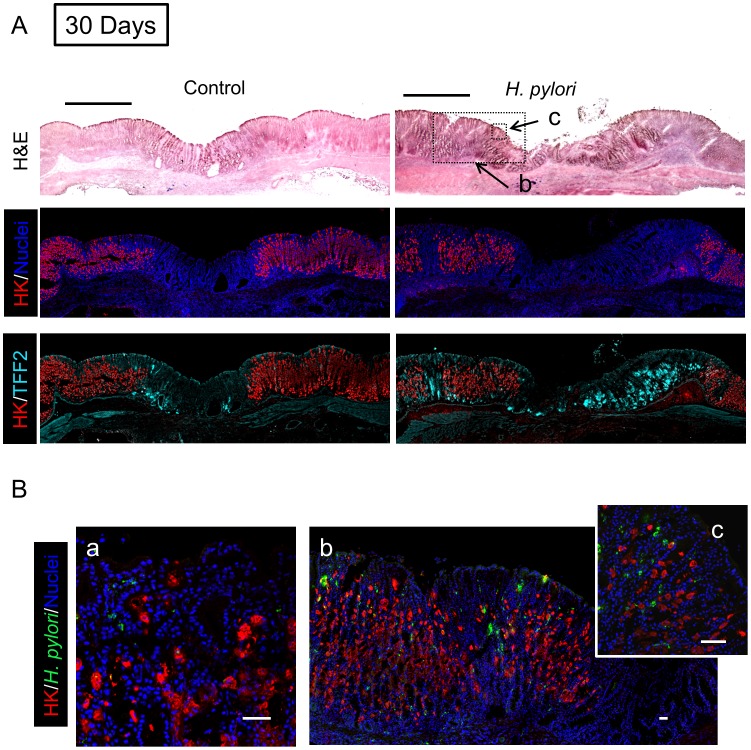
Morphology of gastric ulcerated tissue 30 days after H. pylori inoculation.Gastric tissue was isolated 32 days after ulcer induction (30 Days after H. pylori inoculum), and serial sections processed as described in Methods. (A) Sections of uninfected (control) or H. pylori infected tissues are compared as in Figure 4. Bar = 1 mm. (B) Tissue was also stained for H. pylori, and results presented as in Figure 4. Higher magnification of serial sections from (a) non-ulcerated corpus region of H. pylori infected stomach, or (b, c) around inset area indicated in A. Bar = 50 µm.